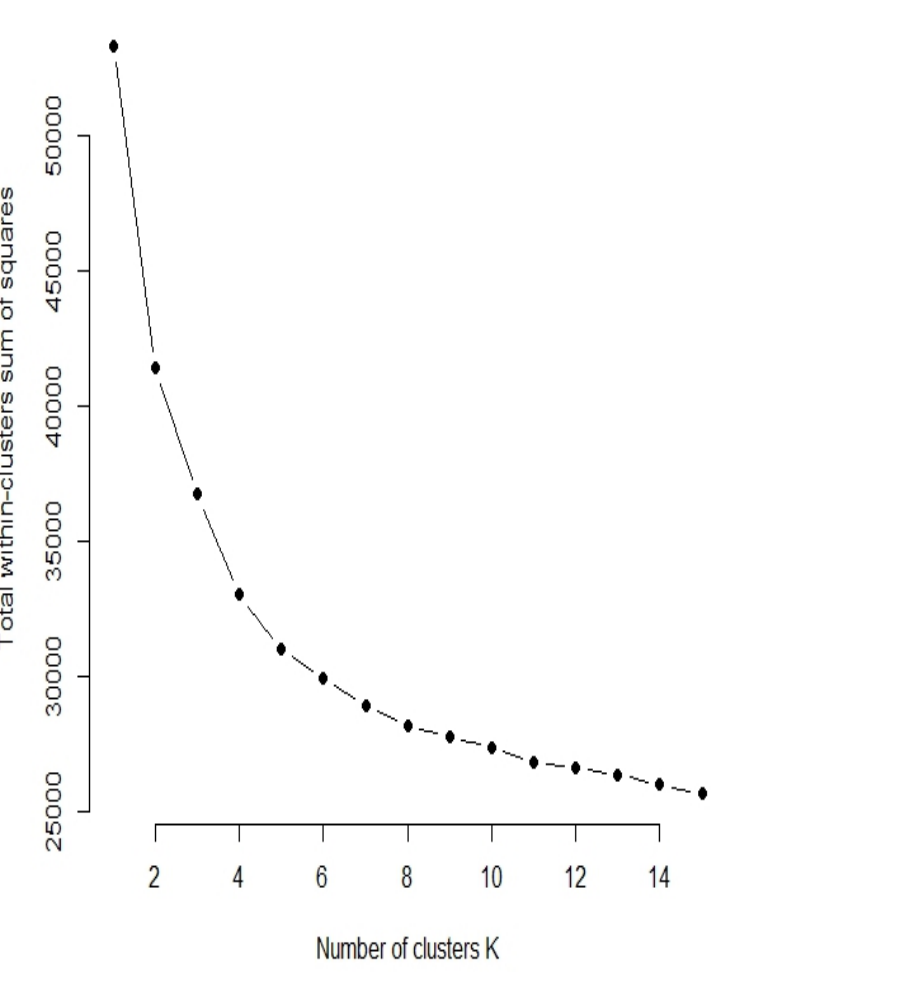
Figure 3. Elbow method result for determining the optimal number of clusters. Table 5. K-means